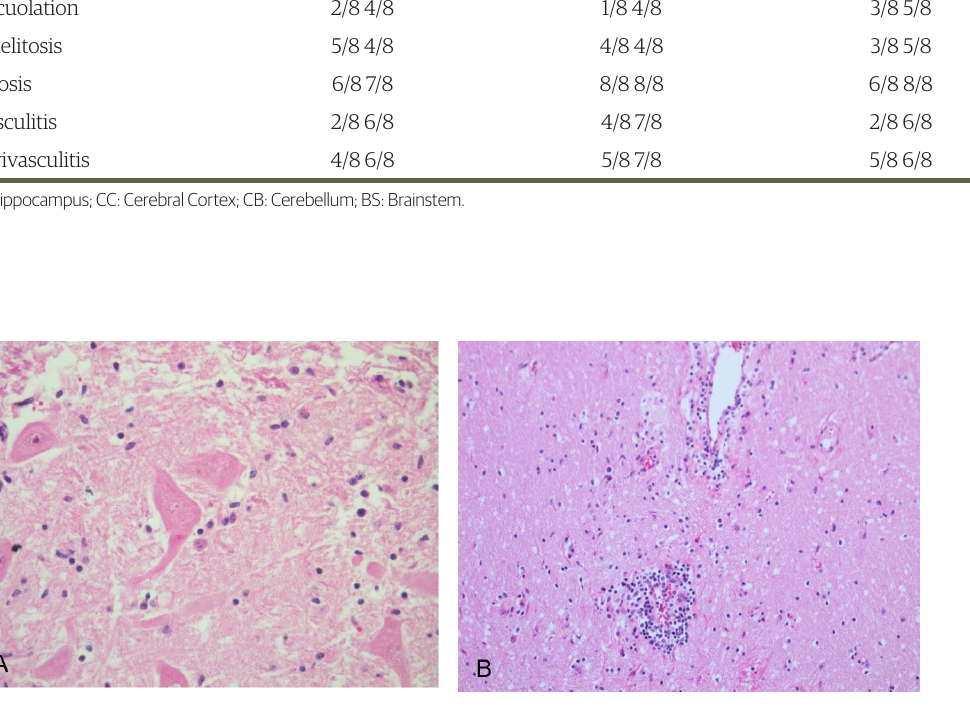
Figure 1. Degenerative process in bovine neurons and presence of Negri bodies (A) and fragment of equine hippocampus with vasculitis and perivasculitis (B) – HE